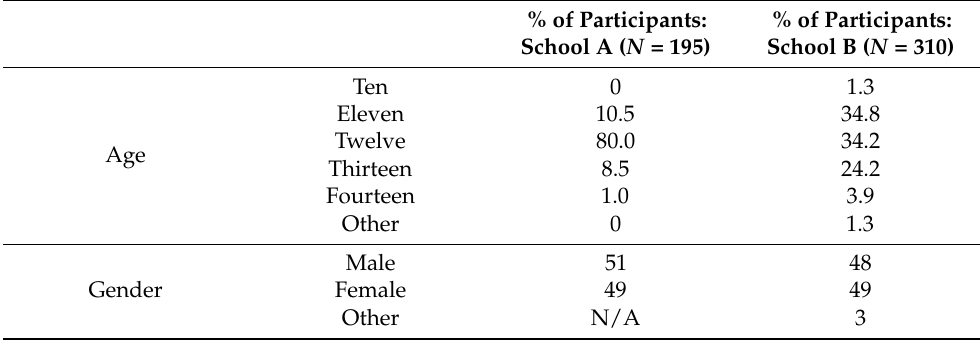
Table 2. Description of students by middle